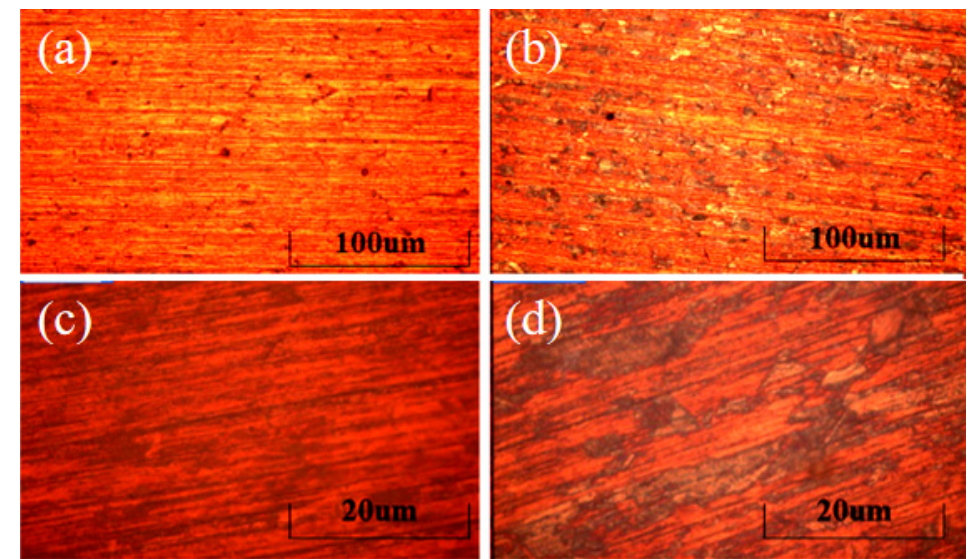
Figure 4. The morphology of TiO 2 film through a BX51M microscope. ( a ) Group A, the heating rate is 11 °C/min and lasts 45 mins, 100 times magnification. ( b ) Group B, the heating rate is 16 °C/min and lasts 30 mins, 100 times magnification. ( c ) Group A with 500 times magnification. ( d ) Group B with 500 times magnification.